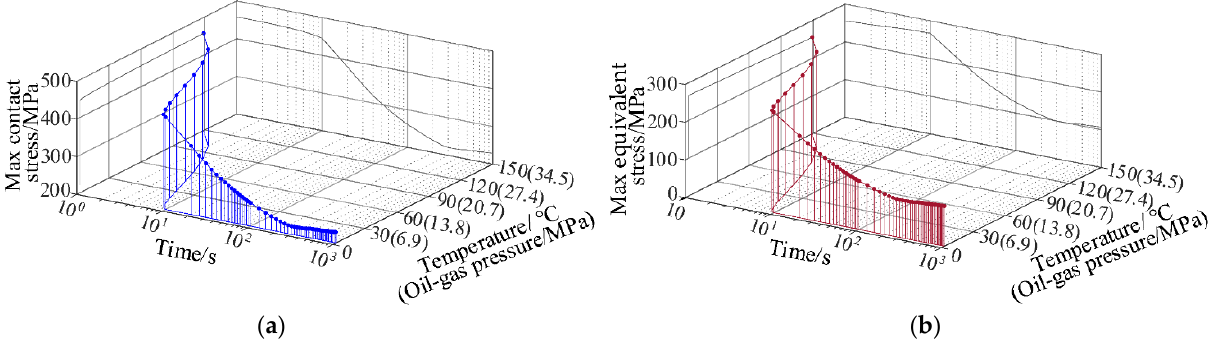
Figure 8. Variations of maximum contact stress and maximum equivalent stress of LSG under the working condition of temperature–pressure instantaneous drop. ( a ) Maximum contact stress; ( b ) maximum equivalent force.